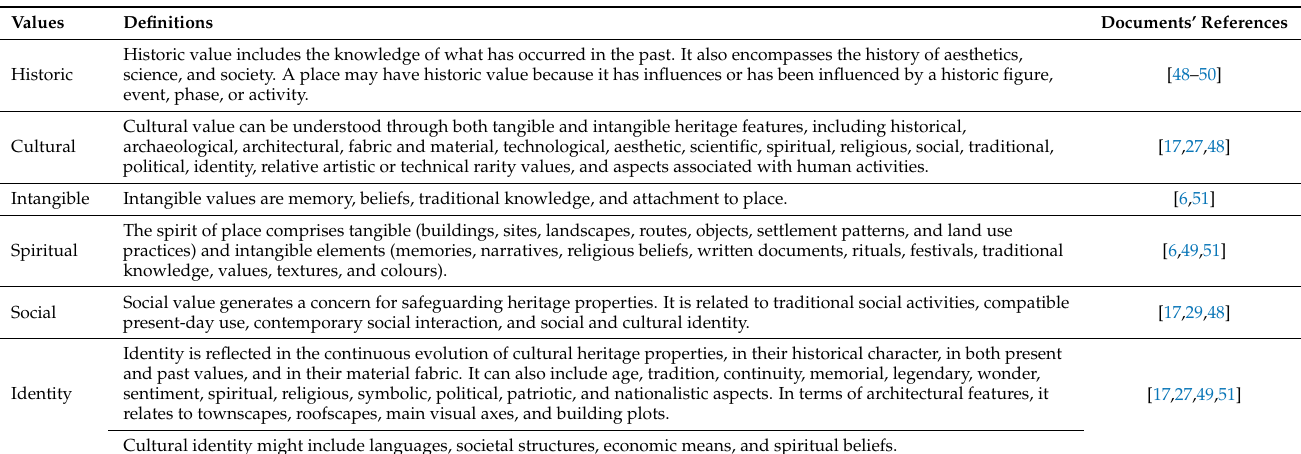
Figure 4. ( a ) Door next to a nightclub. ( b ) La Cibeles perfume shop. Claimed spaces at the time of interviews in the Old Town of Salamanca (2021). Phase 3. Source: Author. Table 3. Main values in WH cities and towns of Spain. Source: Adapted from Alsalloum